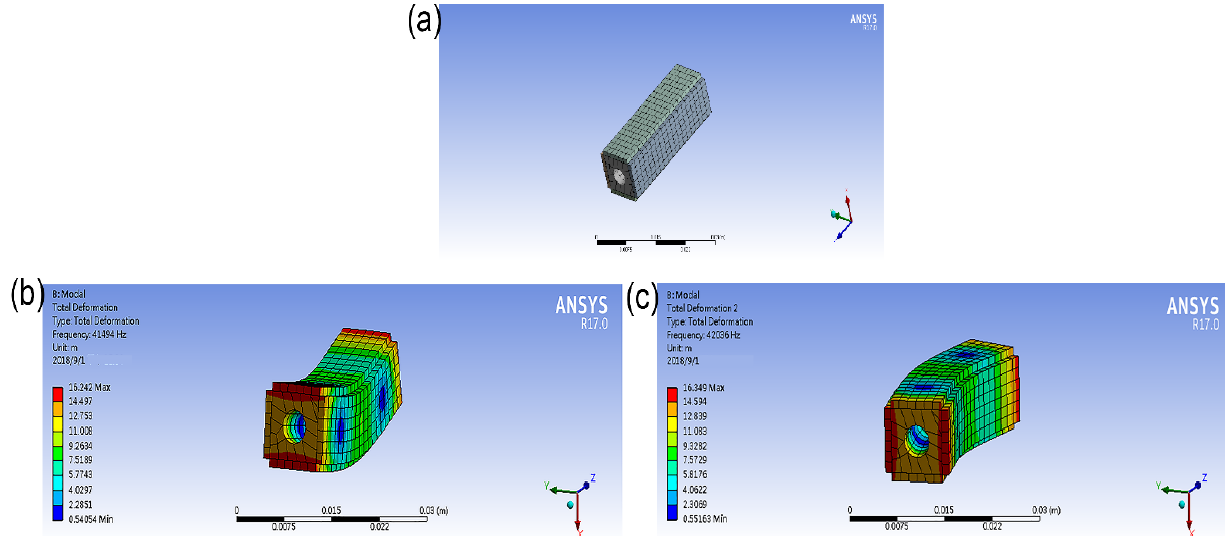
Figure 7. ( a ) The model of piezoelectric motor established by ANSYS ( b ) Bending up and down ( c ) Bending left and right of lead-free piezoelectric motor.